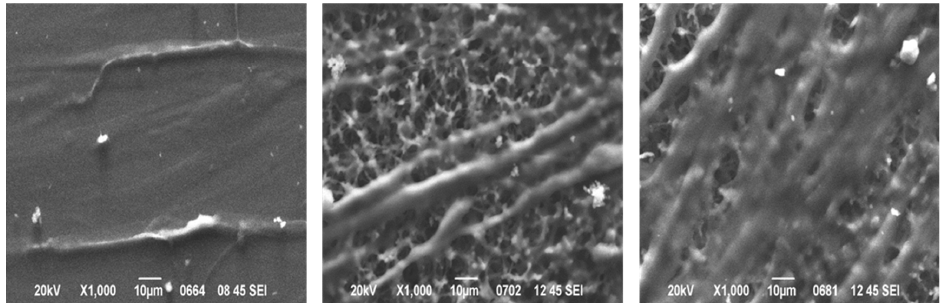
Figure 11. SEM microphotographs of control hDPSCs, hDPSCs cultured on scaffold without pep- tides and hDPSCs cultured on scaffold-BMP2 for 21 days. Photographs were taken at 200× g and 1000× g magnification.